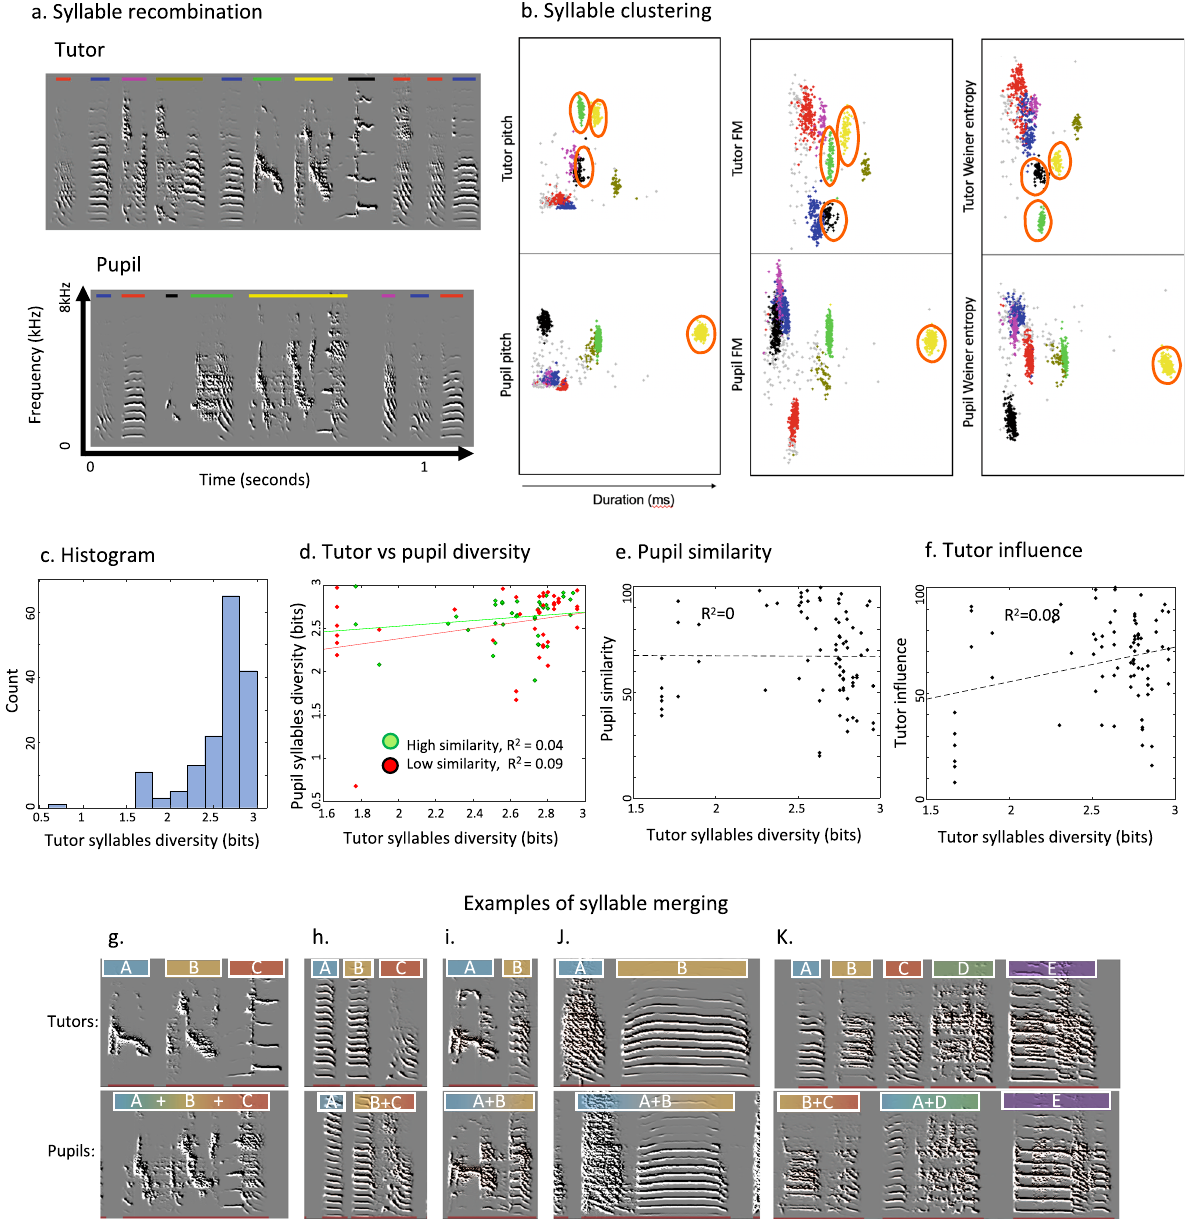
Fig. 3 Syllable-type diversity. a Example sonograms of a tutor – pupil song pair. Syllable types are color-coded by lines above them. Color lines above each syllable indicate clusters computed separately for tutor and pupil in b . Note that syllable types are bird speci fi c and color codes have no correspondence between tutor and pupil, e.g., green, yellow, and black labeled syllable types in tutor song merged into a single type (yellow labeled) in pupil ’ s song. b 2D scatter plots of syllable acoustic features: duration versus mean pitch, mean frequency modulation (FM), or mean Wiener entropy (a measure of the width of the power spectrum). The color of each marker indicates its computed syllable-type (type = cluster in feature space). Colors of clusters correspond to syllable-type colors shown in a . c Histogram of syllable-type diversity, pooled across all birds. d Regression analysis between tutor and pupil syllable-type diversity, showing no signi fi cant correlation for pupils with high or low imitation similarity of their tutors. e , f Tutor syllable diversity is not correlated with pupil song imitation similarity ( e ), or in fl uence of tutors on pupils ( f ). g – k Examples of fi ve tutor – pupil pairs with syllable recombination, namely merging in pupil songs. Source data for this fi gure is in Supplementary Data File